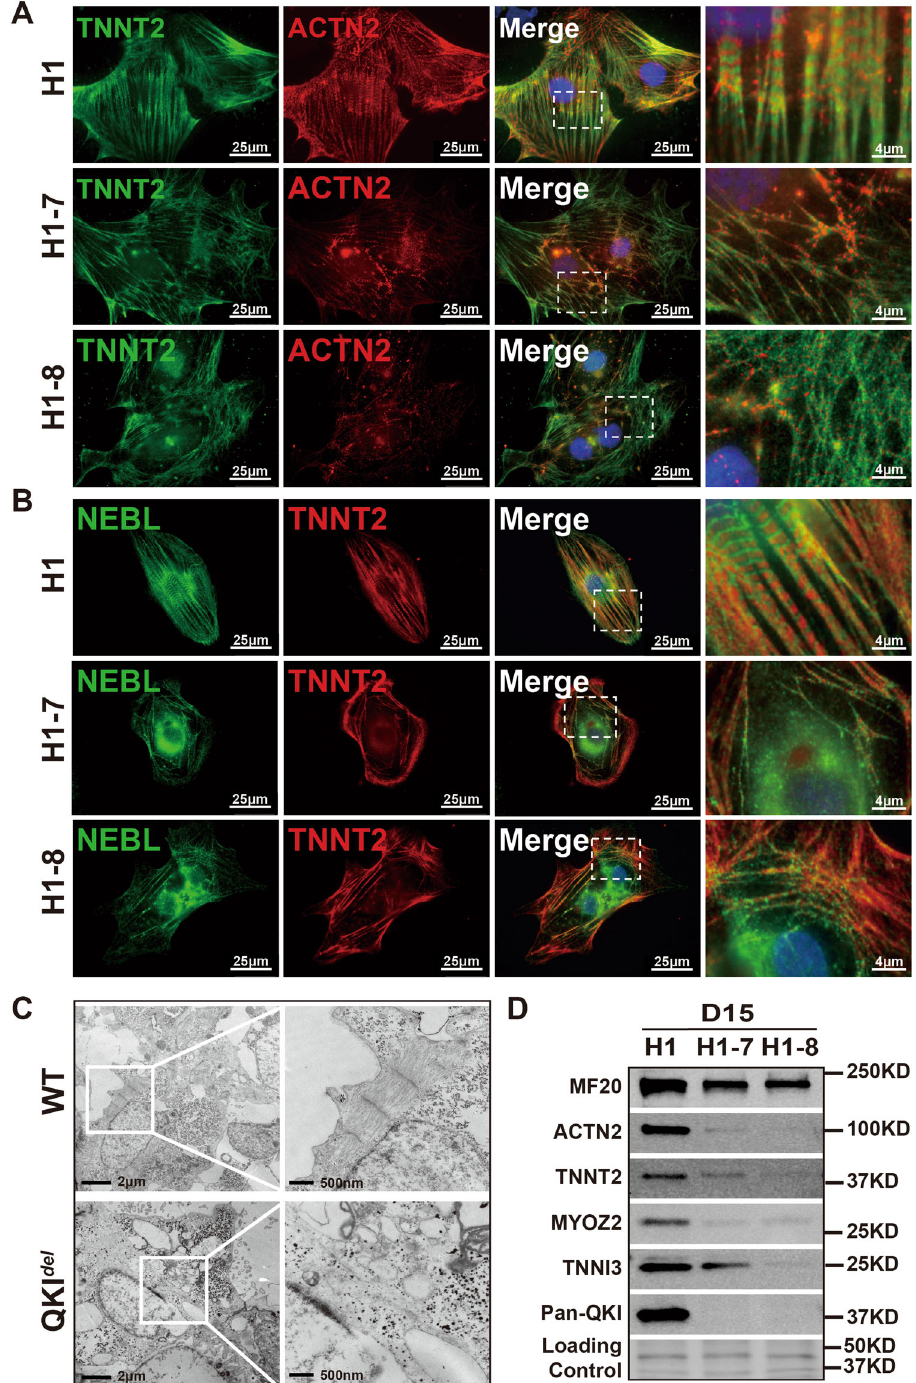
Fig. 7 Severely altered myo fi brillogenesis in hESCs- QKI del -derived cardiomyocytes. A Representative images of immuno fl uorescence staining of TNNT2 (green) and ACTN2 (red) in H1, H1-7, and H1-8 cardiomyocytes at differentiation Day-15. Scale bar: 25 μ m. B Representative images of immuno fl uorescence staining of TNNT2 (red) and NEBL (green) in H1, H1-7, and H1-8 cardiomyocytes at differentiation Day-15. Scale bar: 25 μ m. C Representative transmission electron microscopy images of normal and QKI-de fi cient differentiated cardiomyocytes at Day-15. Scale bar: 2 μ m and 500 nm, respectively. D Western blot analysis of key myo fi brillar proteins in control H1 and mutant H1-7 and H1-8 cardiomyocytes (Day-15). All experiments are independently repeated three times with three different sets of cell samples to ensure the reproducibility of the fi